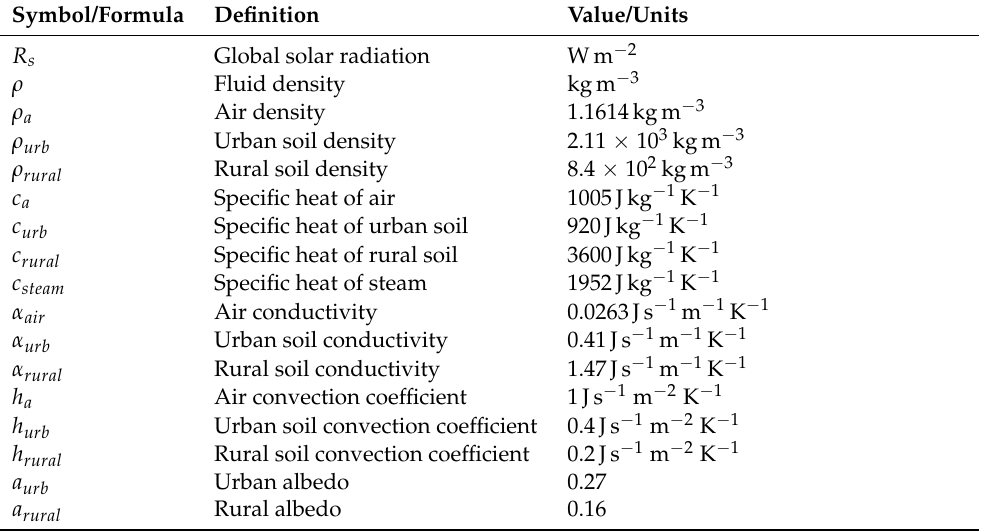
Table A1. Complete list of parameters: Value, definitions, and units [4,11,18,20].